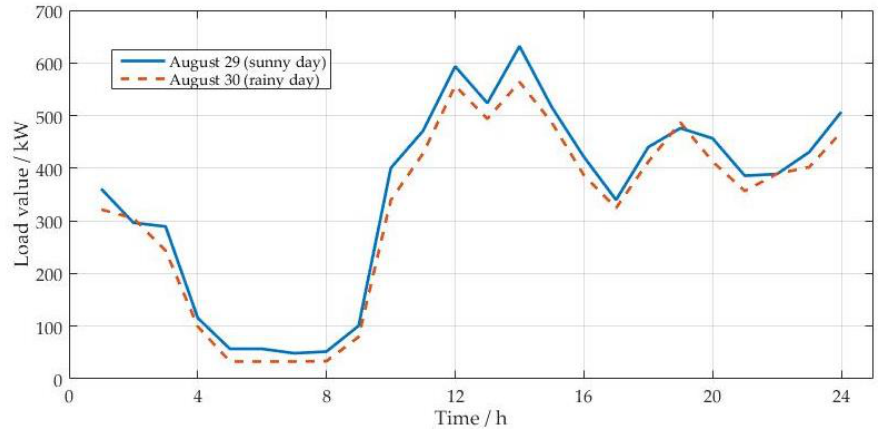
Figure 4 . Relationship between weather conditions and daily load. Figure 4. Relationship between weather conditions and daily